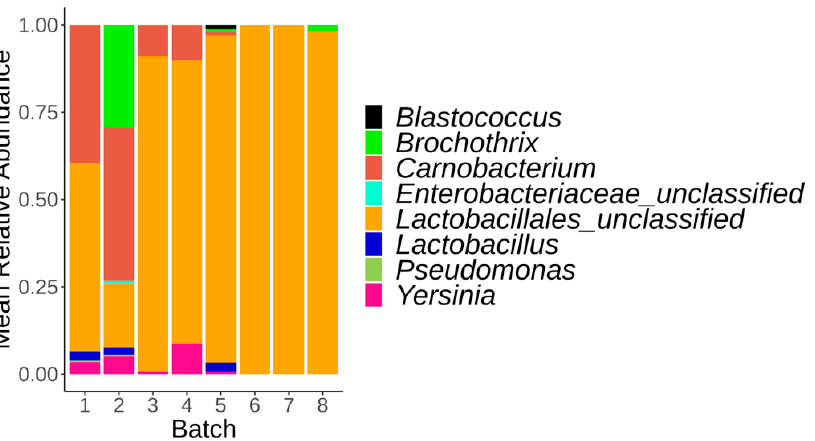
Figure 5. Relative abundance of the major bacterial genera identified on the vacuum-packed pork loin surface microbiota at day 56 for each batch. Only the bacterial genera representing at least 2% of the total reads are shown.